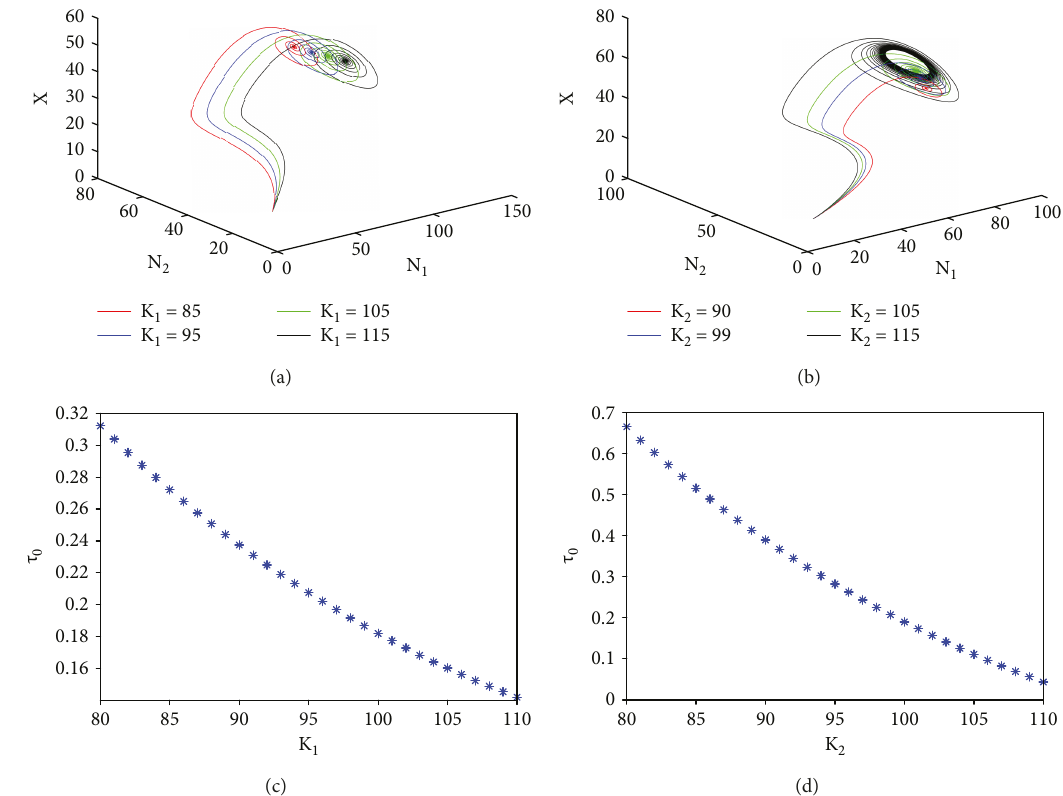
Figure 3: Phase plot diagram of nondelayed model system (1) for di ff erent (a) K and (c) K 1 and (d) K 2 . Rest of the parameters is taken as given in the